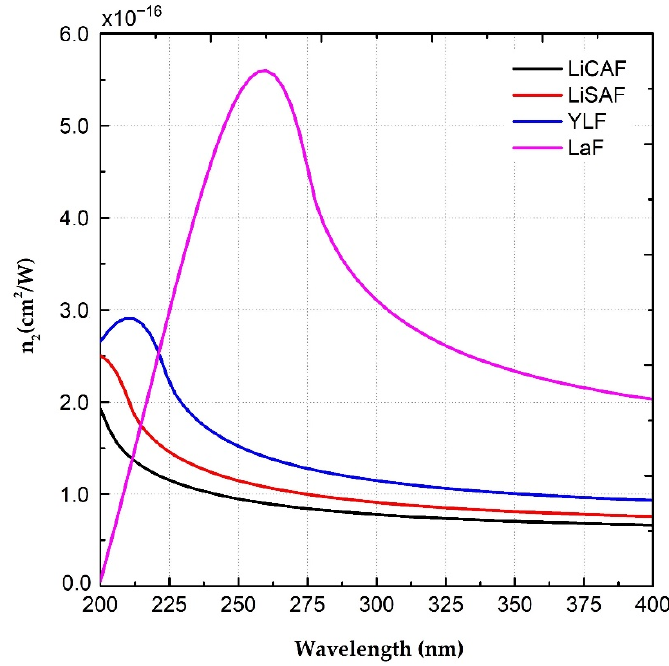
Figure 2. Nonlinear refractive index ( 𝑛 (cid:2870) ) of the fluoride laser materials.